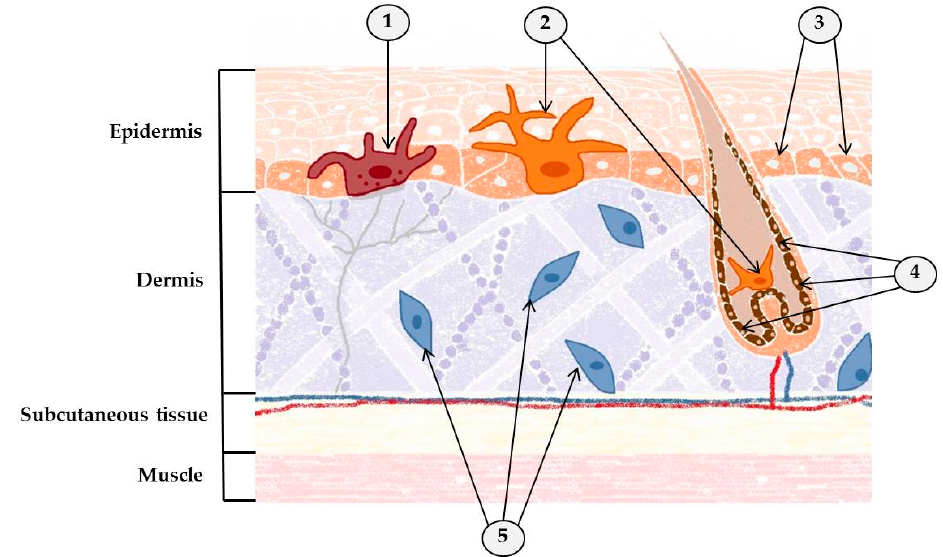
Figure 2. The origins of various types of skin cancer. 1—Merkel cell (Merkel cell carcinoma); 2—melanocytes (melanoma); 3—basal cells (basal cell carcinoma and squamous cell carcinoma); 4—keratinocytes (basal cell carcinoma); 5—fibroblasts (dermatofibrosarcoma protuberans).